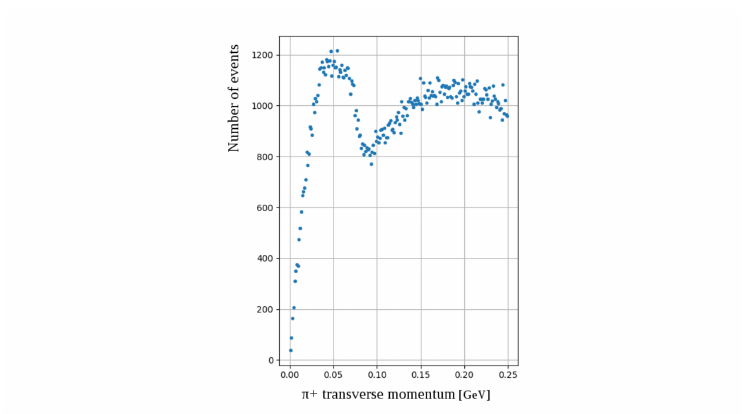
Figure 2. Distribution of π + mesons (resulting from the reaction e + e − → DD ∗ ) on their transverse momentum